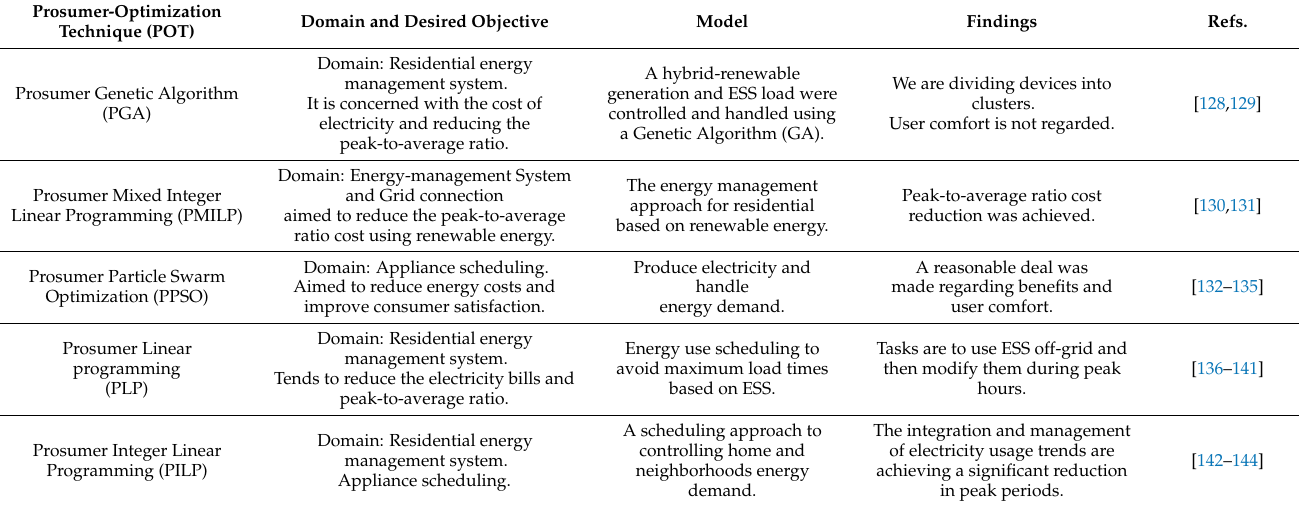
Table 4. Comparison of optimization PEM